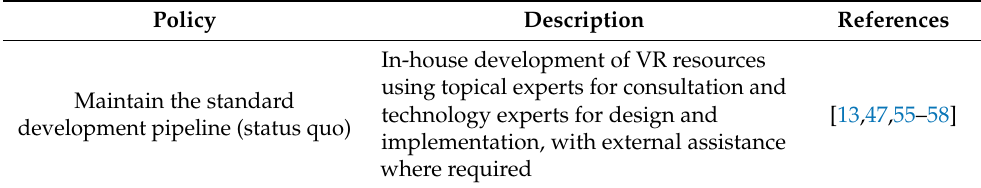
Table 2. Policy alternatives for immersive resources